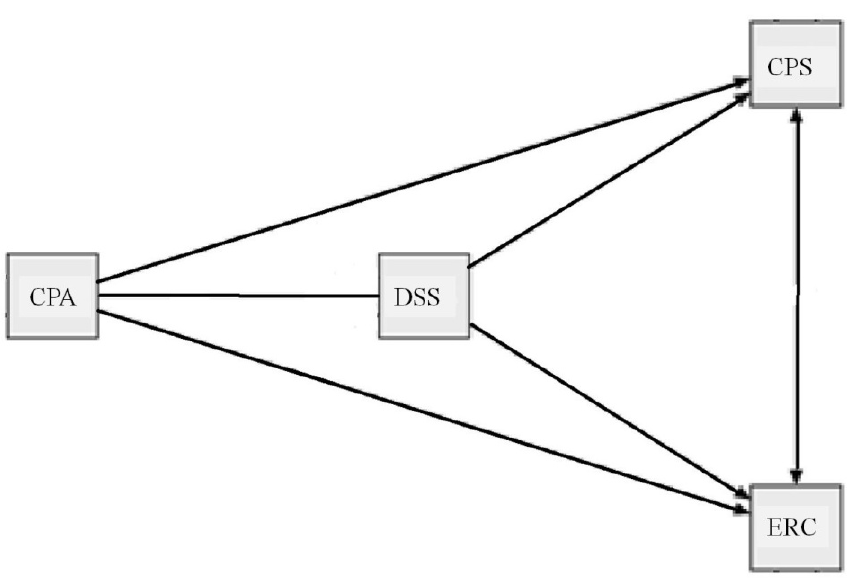
Figure 2. Mediation model hypothesis. Note: CPA—Positive attitude; DSS—Decentering Sport Scale; CPS—Problem solving; ERC—Cognitive Reappraisal.